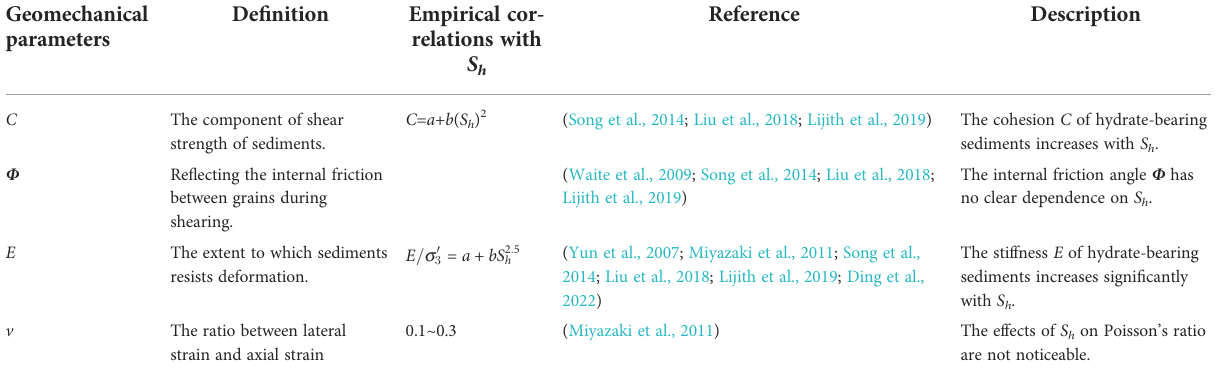
TABLE 4 Several correlations of geomechanical properties and S h .